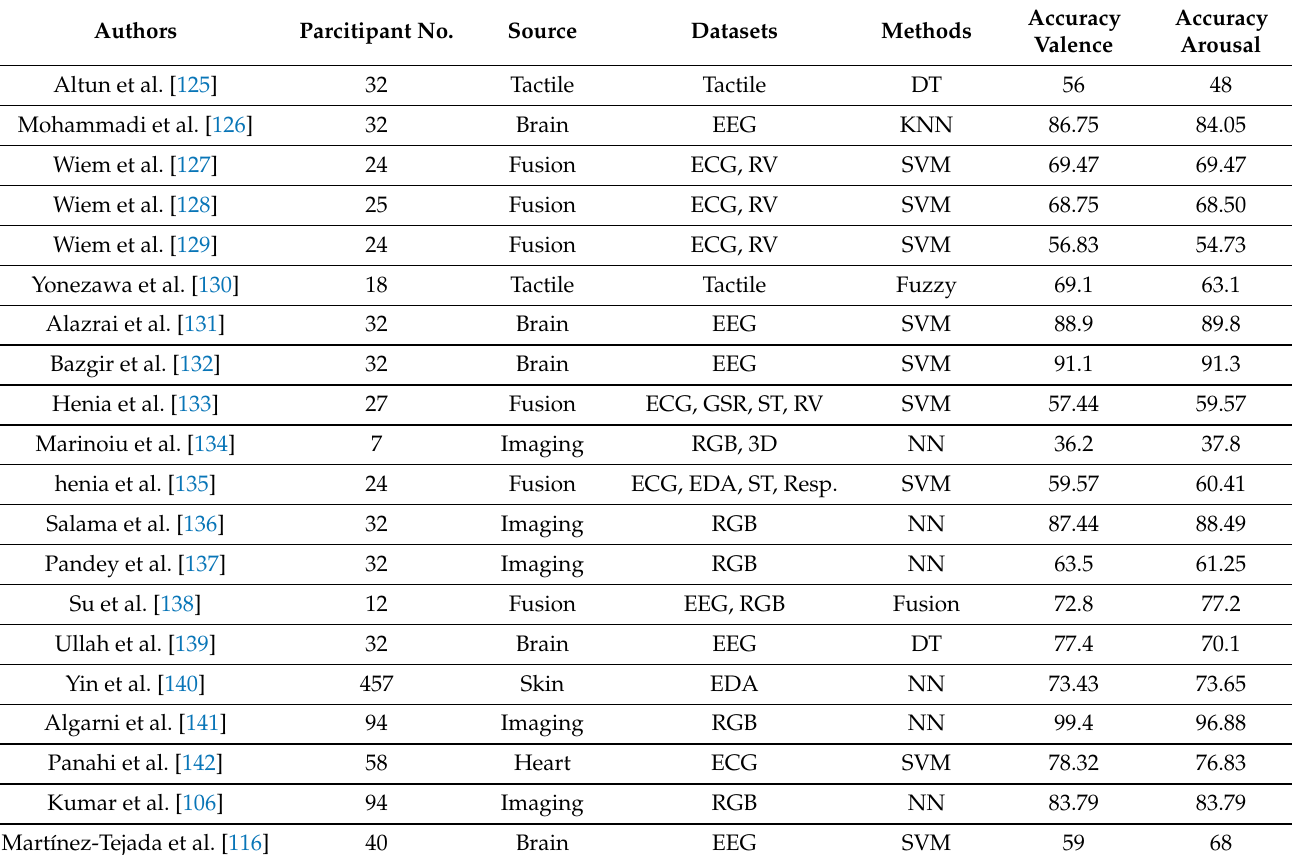
Table 2. Summary of the included papers in the valence-arousal emotional